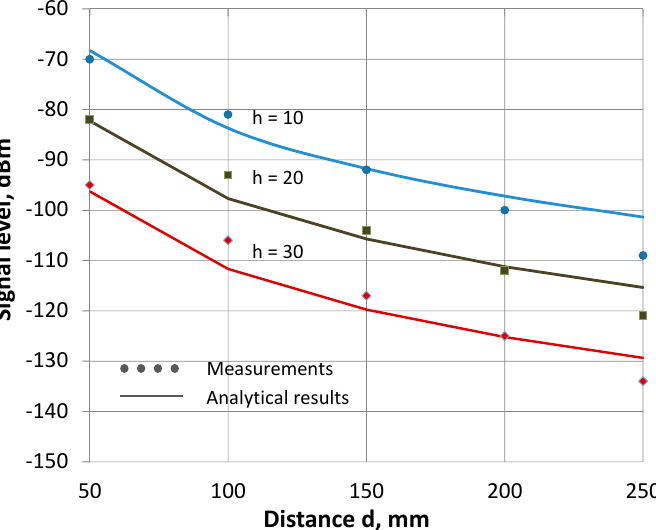
Figure 7. Measured signal power level versus distance d between the reader antenna and the box with the tissue-equivalent liquid for different values of distance h between the implanted dipole and the tissue surface. The results of calculation by (8)–(10), taking into account the path loss and medium mismatching, are shown by solid lines, and the dots present the measured results.